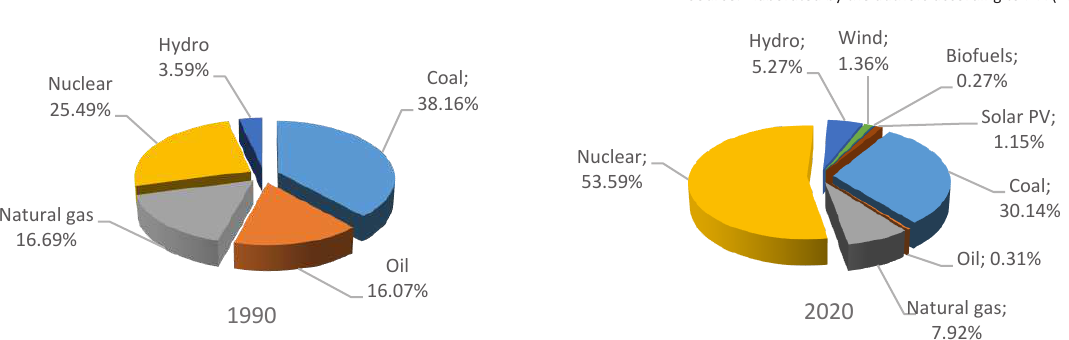
Figure 3. Power generation by source in Ukraine in 1990 and 2020, %